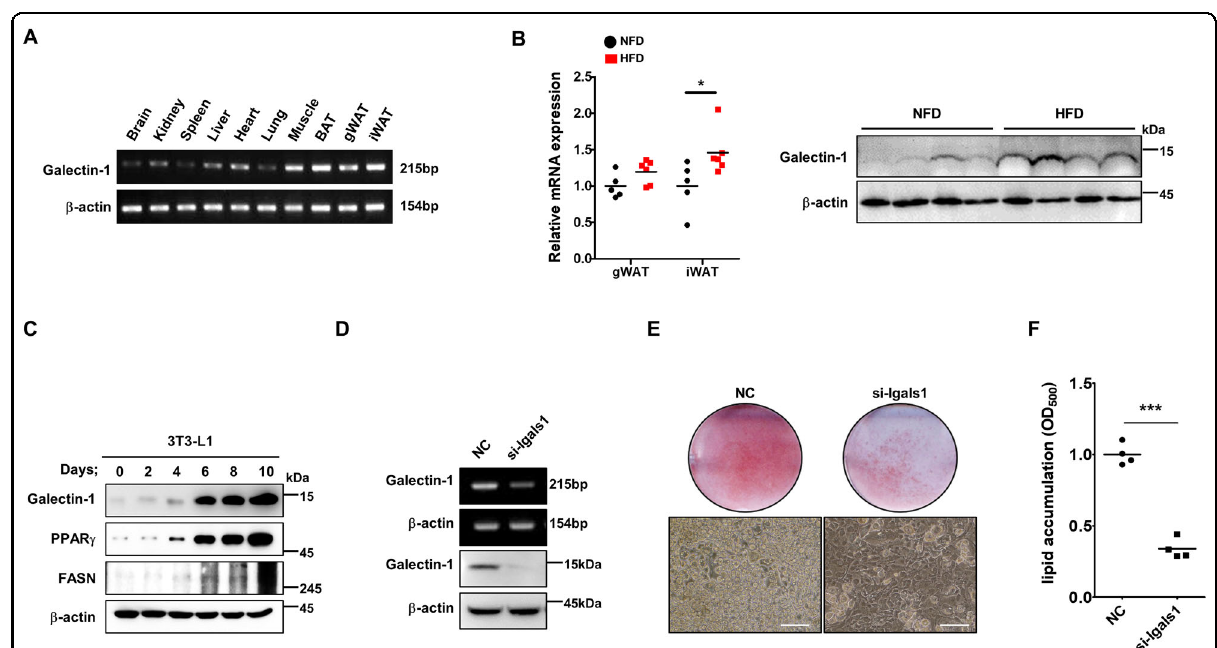
Fig. 1 Galectin-1 expression during adipocyte differentiation and in mouse adipose tissues. a The expression of galectin-1 mRNA in mouse tissues was analyzed by RT-PCR. β -actin mRNA expression was used as a loading control. b The level of galectin-1 mRNA and protein was analyzed by quantitative RT-PCR and western blotting in gonadal white adipose tissues (gWATs) and inguinal (iWATs) from mice fed a normal-fat diet (NFD) or a high-fat diet (HFD) for 12 weeks. Data are presented as the mean ± standard error of the mean (SEM). * p < 0.05 for the NFD group ( n = 5) vs. the HFD group ( n = 6). c The protein level of galectin-1 and lipogenic proteins, such as PPAR γ and FASN was analyzed by western blotting during DMI (dexamethasone, methylisobutylxanthine, insulin) induced differentiation of preadipocyte 3T3-L1 cells. β -actin expression was used as a loading control. d The expression level of galectin-1 mRNA and protein was analyzed by RT-PCR (two upper panels) and western blotting (two lower panels) after galectin-1 knockdown by a speci fi c siRNA in 3T3-L1 cells. The mRNA and protein expression levels were normalized to those of β -actin. e Detection of adipocyte differentiation of 3T3-L1 cells following galectin-1 silencing. The cells were treated with galectin-1 siRNA and differentiation was induced by DMI treatment for 6 days. Oil red o (ORO) staining was performed to detect lipid accumulation (upper fi gures) and the staining level was taken by picture. Cell morphology was detected (lower fi gures) by microscopy. Bars indicated 50 μ m. f Measurement of lipid accumulation. The ORO dye (used for staining) was eluted with 100% isopropanol and the optical density at 500 nm (OD 500 ) was detected. *** p < 0.001 for the NC group vs. the galectin-1 siRNA